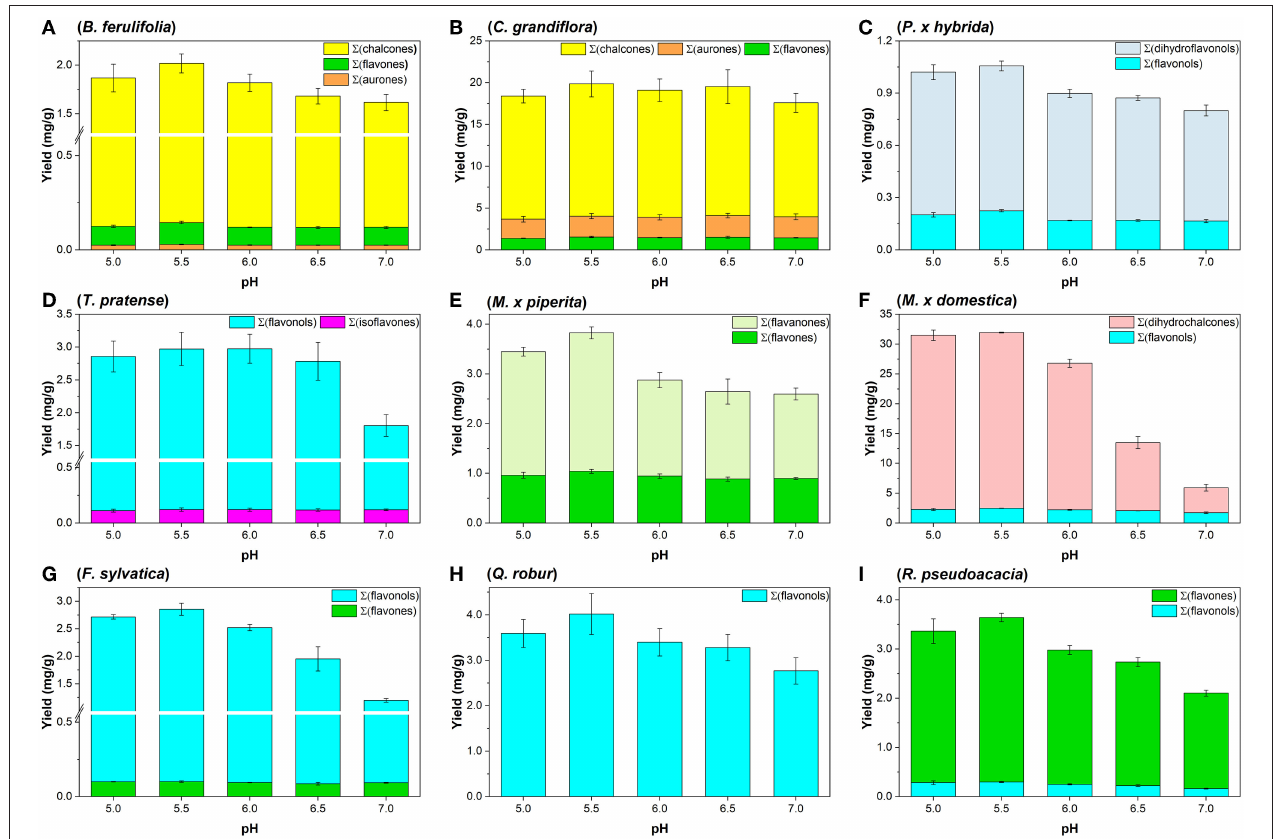
FIGURE 2 | Summarized aglycone yields (mg/g) in methanolic plant extracts after hydrolysis by snailase (5mg per assay) at 37 ◦ C for 25min between pH 5.0–7.0. (A) B. ferulifolia ; (B) C. grandiflora ; (C) P. × hybrida ; (D) T. pratense ; (E) M. × piperita ; (F) M. × domestica ; (G) F. sylvatica ; (H) Q. robur ; (I) R. pseudoacacia ( n = 3 ±